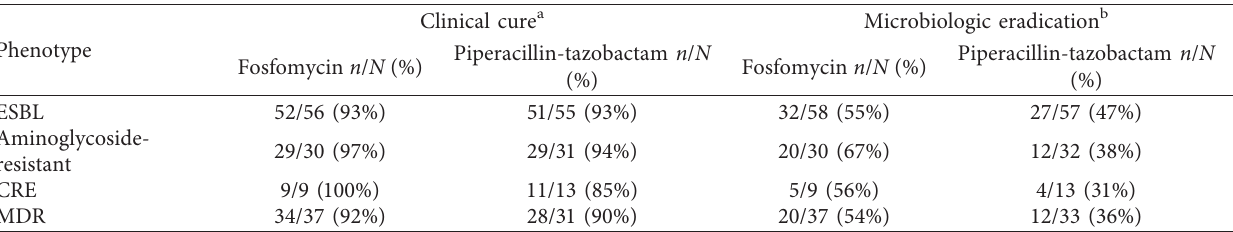
Table 3: Clinical cure and microbiologic eradication outcomes of ZTI-01 (intravenous fosfomycin) versus piperacillin-tazobactam in patients with complicated urinary tract infections (cUTI) and acute pyelonephritis (AP), due to baseline pathogens with resistant phenotypes.